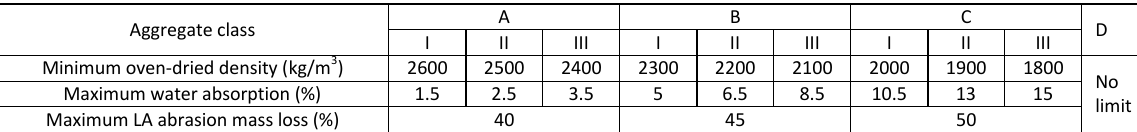
Table 1. Physical property requirements of the performance-based classification (adapted from Silva et al. [24]). Aggregate